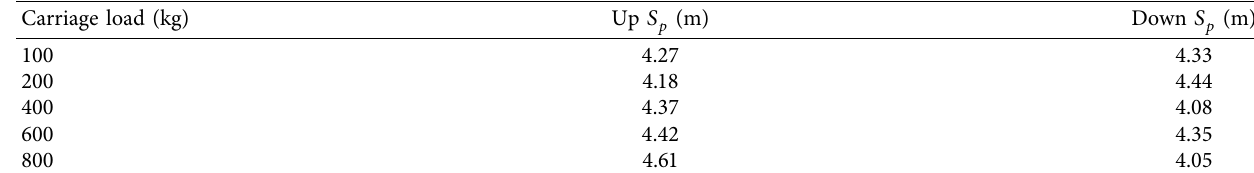
Table 1: Upward and downward stop